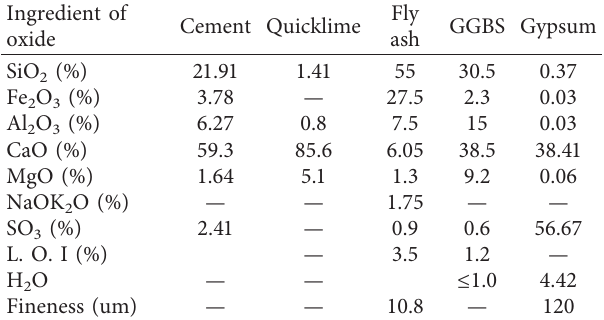
Table 2: Chemical analysis of binder materials.